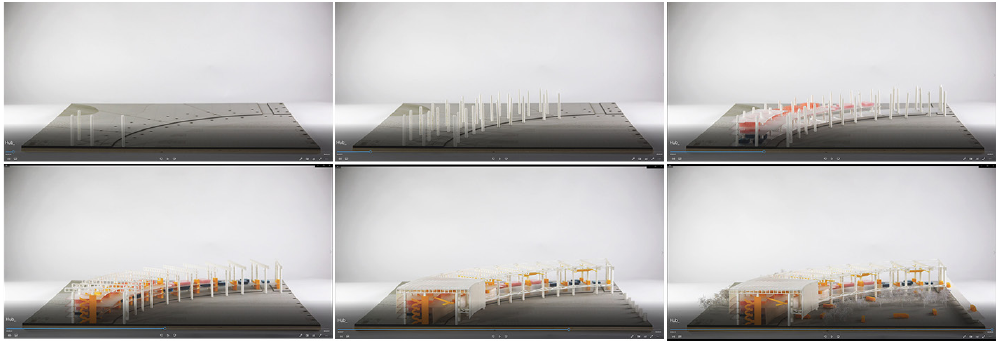
Fig. 8 Bertola, G., Pupi, E., Awada, Frame of the stop-motion video of the Logistic Hub ,